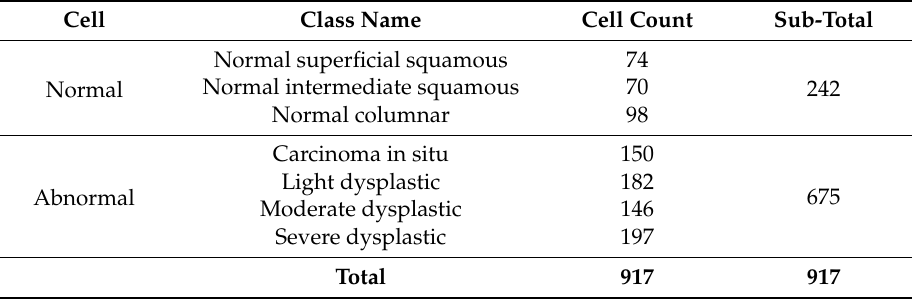
Table 4. Classification of Pap smear single image cell types in the Herlev dataset